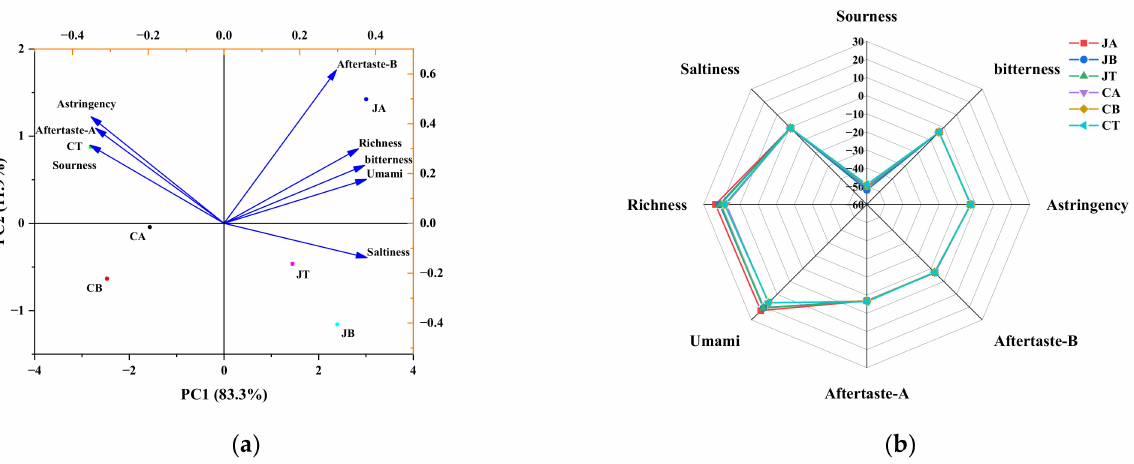
Figure 4. Principal component analysis (PCA) ( a ) and radar chart ( b ) of E-tongue data for different parts of JPGC and CGC. JPGC: grass carp from Jingpo Lake; CGC: commercial grass carp; JA: abdomen of JPGC; JB: back of JPGC; JT: tail of JPGC; CA: abdomen of CGC; CB: back of CGC; CT: tail of